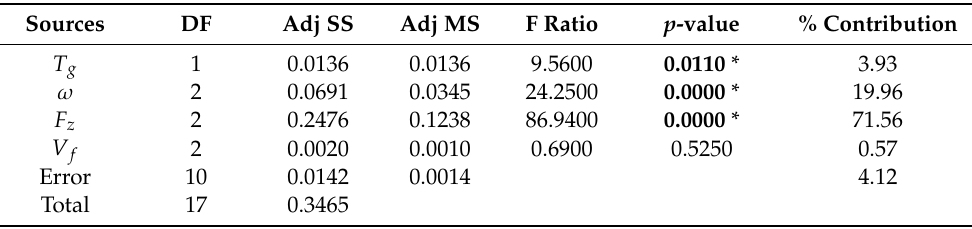
Table 5. ANOVA table for polishing efficiency ( PE ).